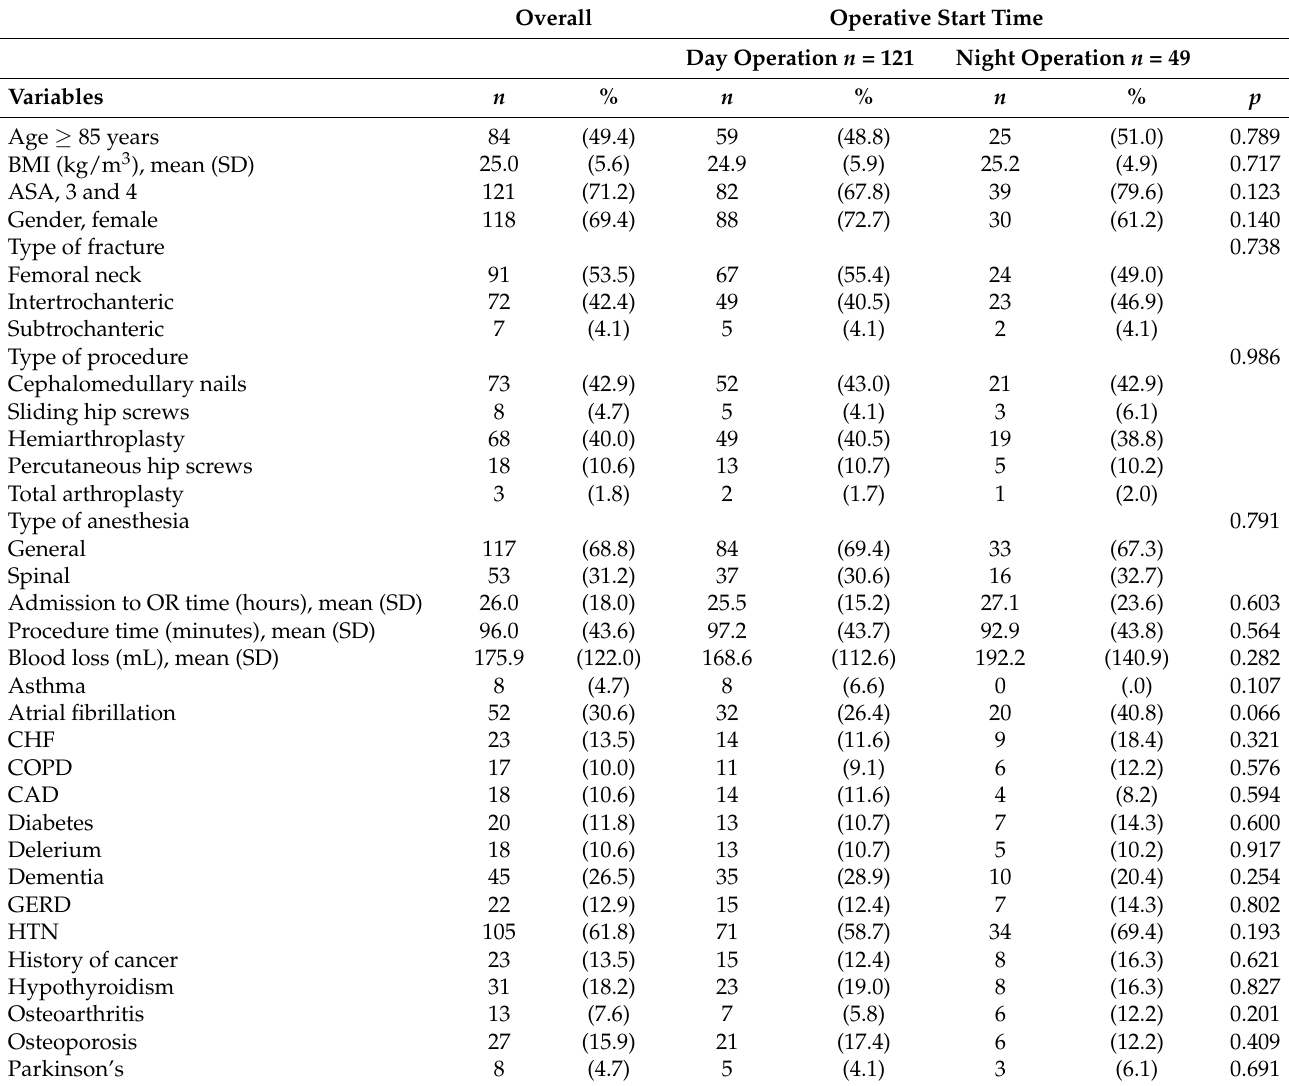
Table 1. Clinical Characteristics of Overall Study Group and Operative Start Time Groups ( n = 170).